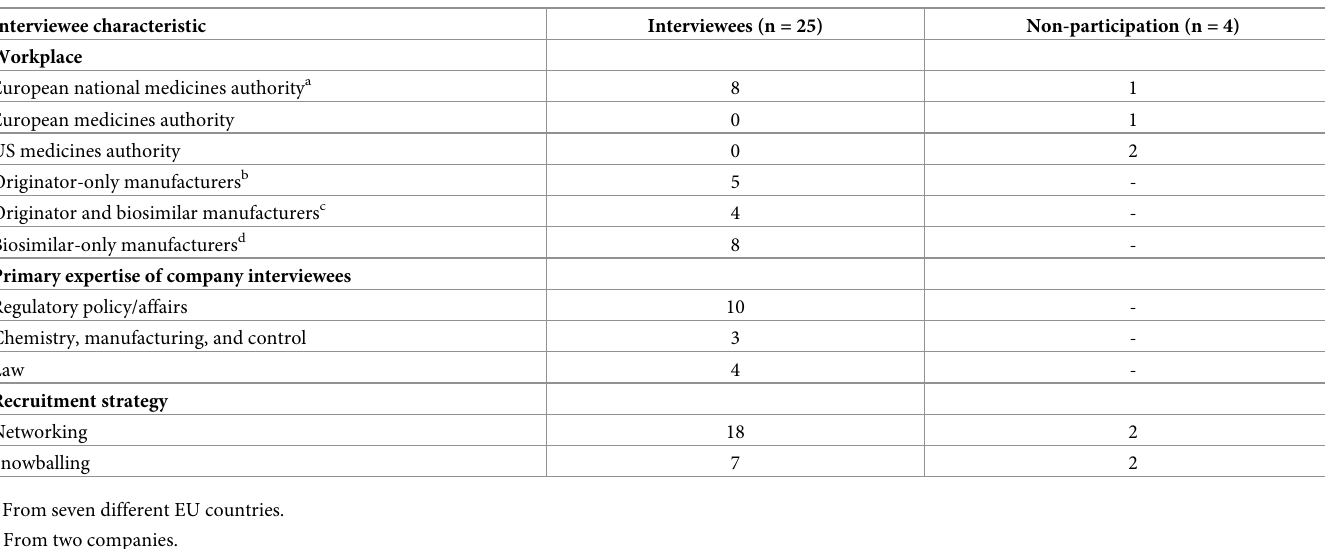
Table 2. Interviewee characteristics and those invited that did not participate. Values are number of interviewees.